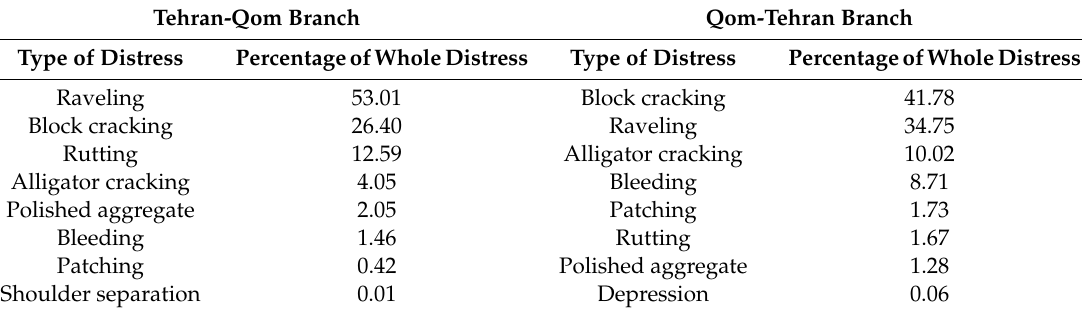
Table 5. Surface Distresses in Tehran-Qom freeway.